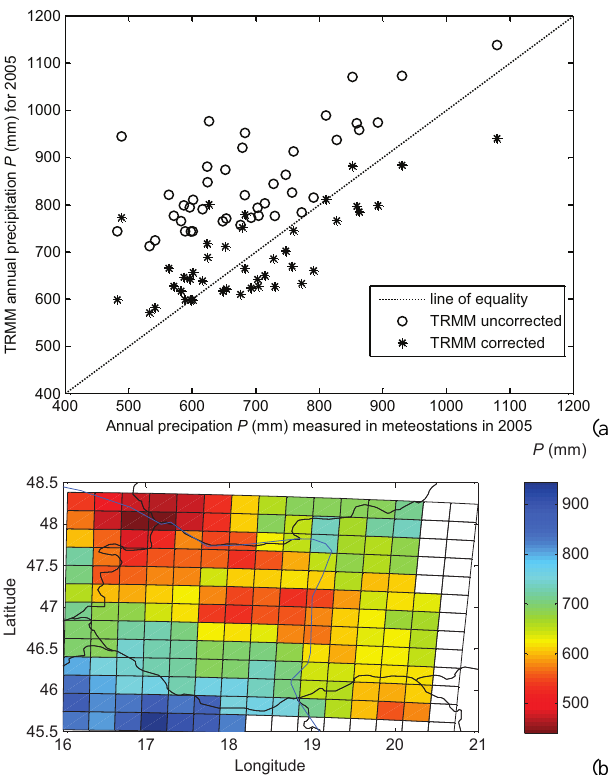
Fig. 3. Annual precipitation P (mm) over 2005 in the test area (a) measured at meteostations and the corresponding corrected and uncorrected TRMM observations and (b) corrected TRMM observations, being projected at a spatial resolution of 0.25 ◦ . The standard error of the bias-corrected TRMM product is about